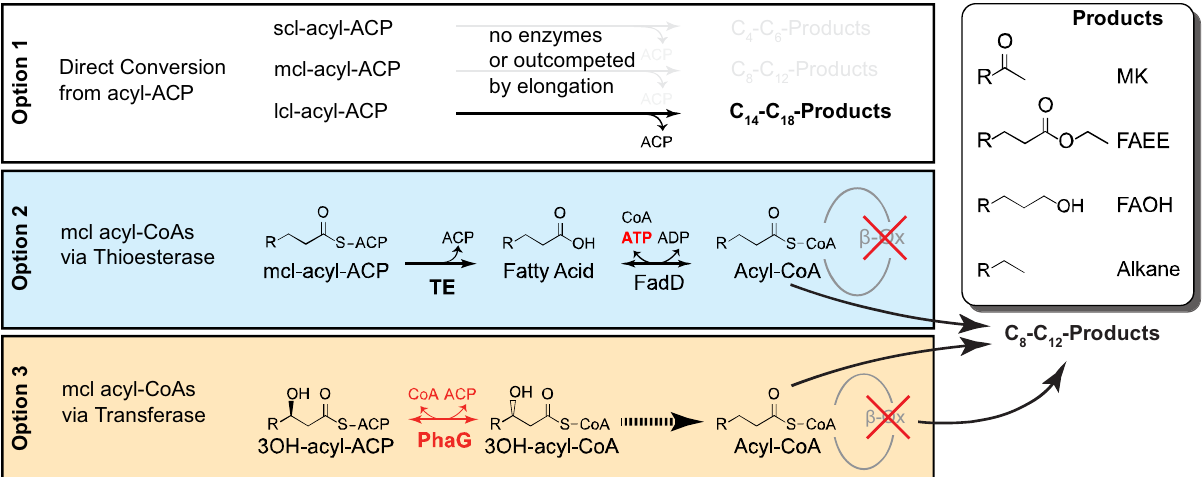
Fig. 1 Metabolic pathways for producing medium-chain oleochemicals via fatty acid biosynthesis. Oleochemical products such as methyl ketones (MK), fatty acid ethyl esters (FAEE), fatty alcohols (FAOH), and alkanes are made by enzymes that act on acyl-thioesters. Many oleochemical-producing enzymes can act on long-chain acyl-ACPs (Option 1) but fail to produce medium or short-chain products in high amounts without additional genetic modi fi cations. The reduced activity is likely caused by lower concentrations of shorter chain length acyl-ACPs and/or reduced speci fi c activity on these substrates, particularly when compared to enzymes in fatty acid biosynthesis that elongate the same substrates. Alternatively, if β -oxidation is blocked (often by deleting enzymes catalyzing the appropriate step in the cycle), higher concentrations of mcl-acyl-CoA ’ s can be provided to saturate oleochemical-producing enzymes. This acyl-CoA pool can be created either by the combination of thioesterase (TE) and acyl-CoA synthetase (e.g., FadD) activity (Option 2) or by acyl-transferase activity (Option 3). Transferase activity (e.g., PhaG) saves one ATP per product relative to Option 2. Detailed pathways for Options 2 and 3 are illustrated in Supplementary Fig.